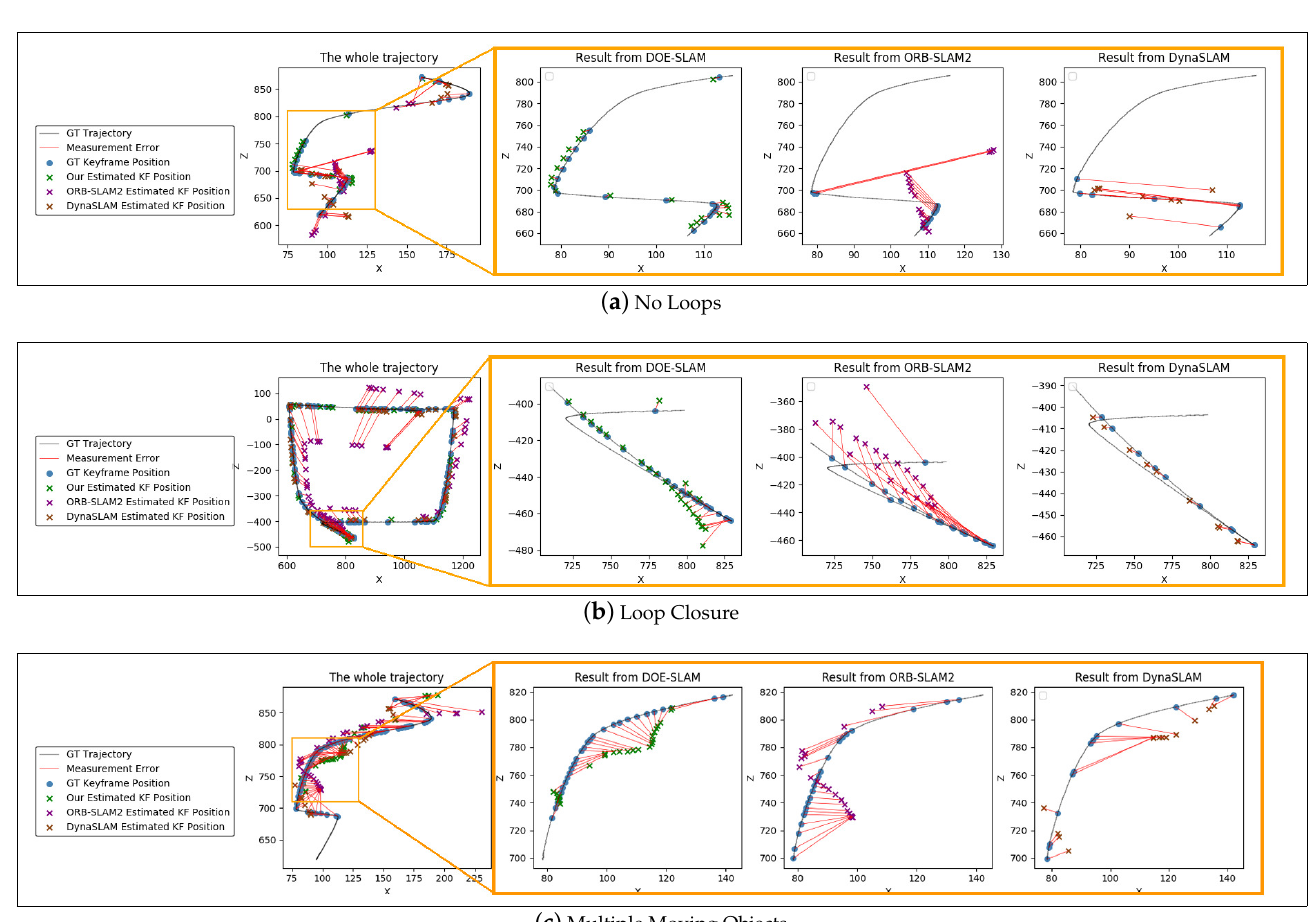
Figure 6. Fully dynamic scenes. Overview of complete trajectories with marked successful tracking steps for DOE-SLAM, ORB-SLAM2, and DynaSLAM and a magnification of the region where the moving object is in